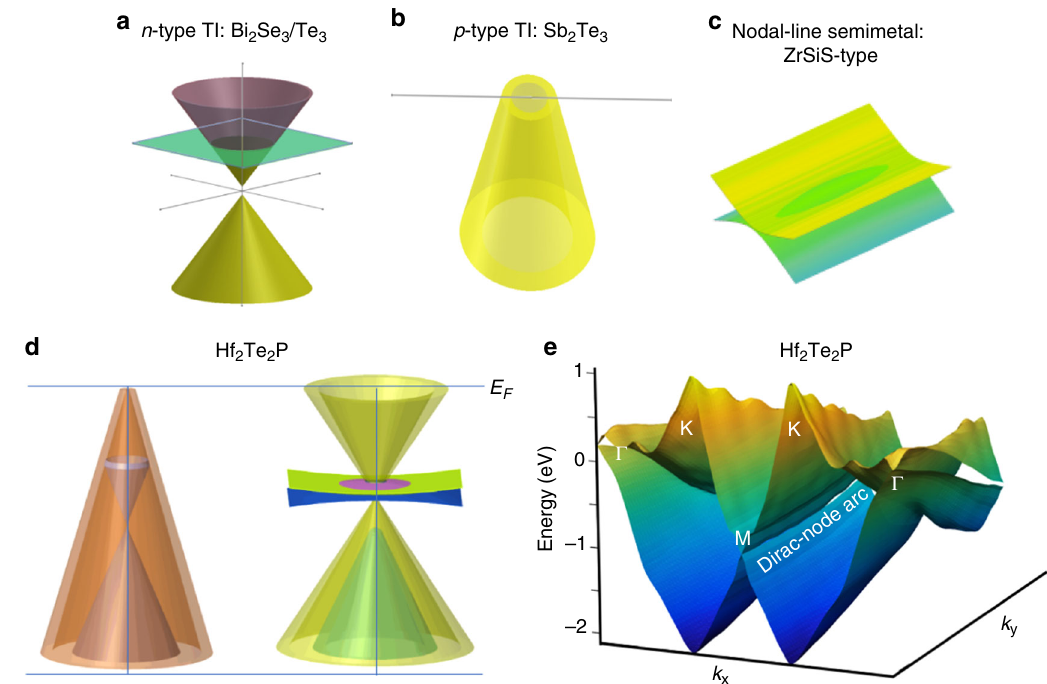
Fig. 5 Schematic view of distinct fermionic states. a , b Sketch of electronic surface state dispersion of the n -type topological insulator and p -type topological insulator, respectively. c Dispersion of bulk states in a nodal-line semimetal of ZrSiS-type. d Sketch of electronic dispersions of the 221-material Hf 2 Te 2 P. This material consists of both n - and p -type topological surface states as well as a surface Dirac-node arc phase. e View of the calculated surface electronic structure of this material that con fi rms its weak topological nature, also showing the Dirac-node arc starting at M. The Dirac-node arc is purely surface-derived, in contrast to the nodal-line semimetal phase shown in c , which is